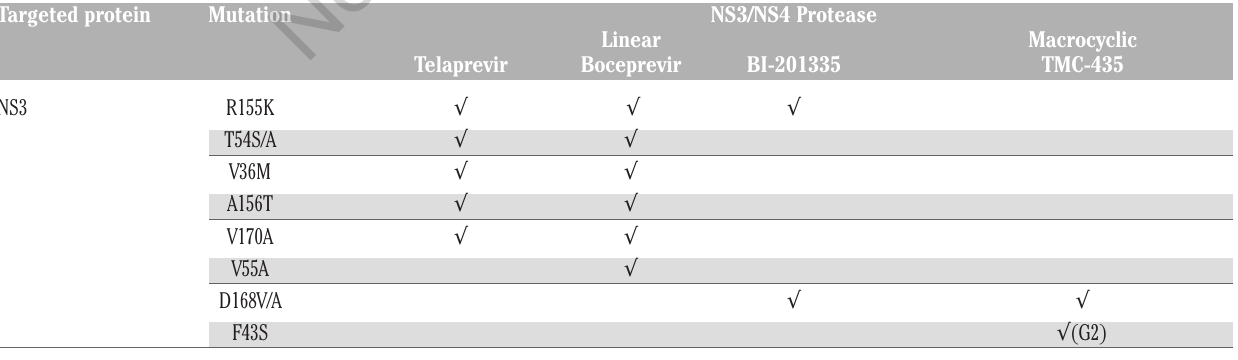
Table 2. Amino-acid substitutions in the NS3 serine protease of HCV which confer resistance to linear and macrocyclic inhibitors. NS4 is a co-factor required for efficient proteolytic processing of the viral polyprotein. Targeted